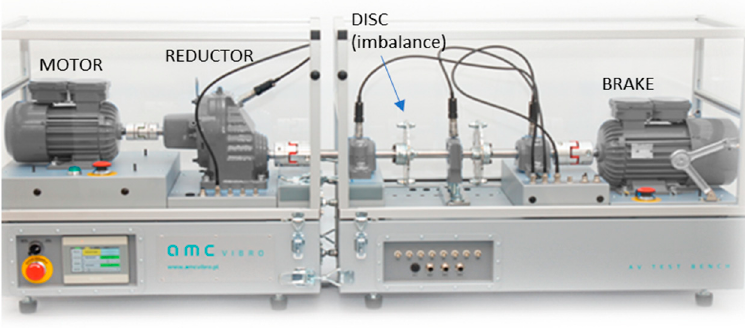
Figure 6. Test bench.